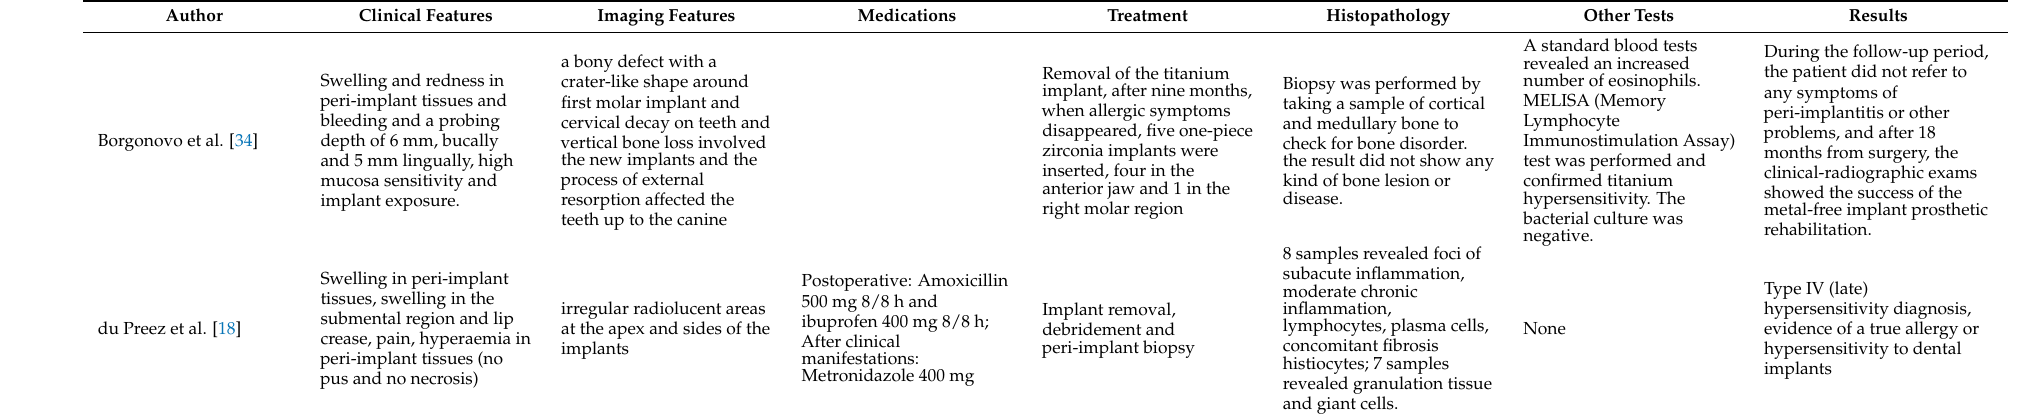
Table 2. Overview of the characteristics of the lesions, the type of medications and treatments, additional tests and